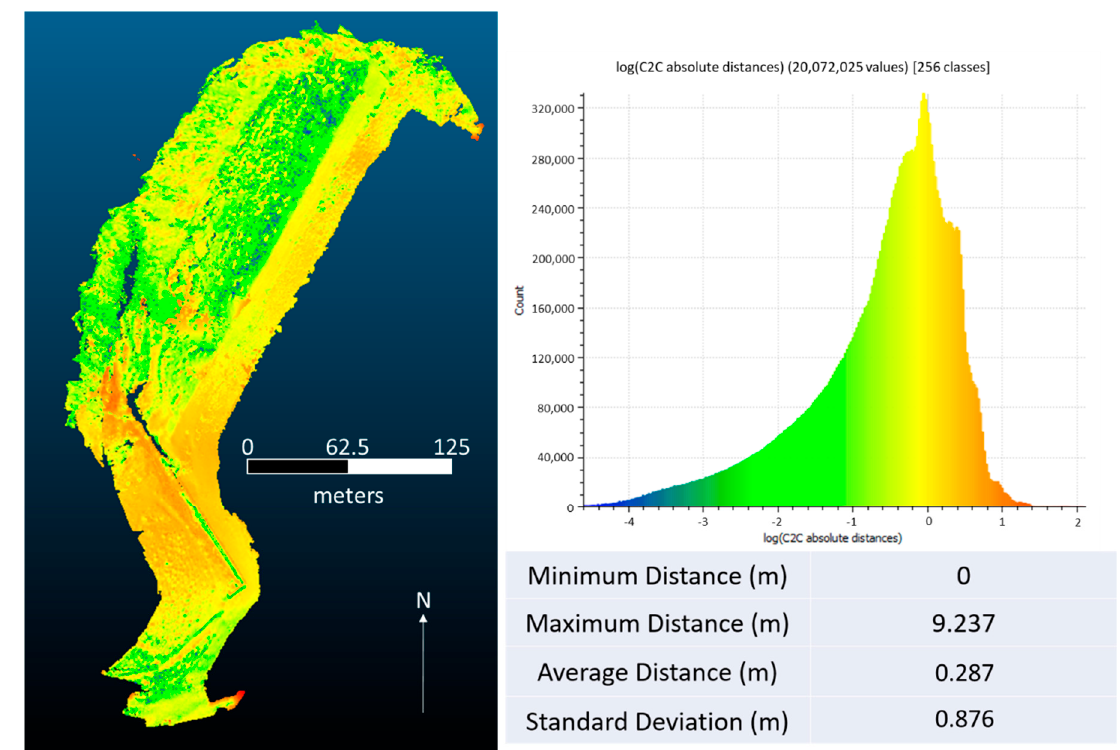
Figure 11. Difference in models when GCP is mis-tagged vs. GCP being properly tagged. These are Euclidian distances measured in 3D.